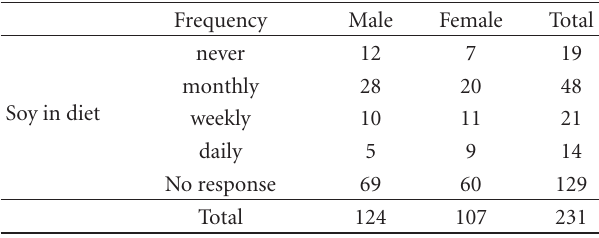
Table 5: The relationship of soy in the diet to the sex of the fetus.